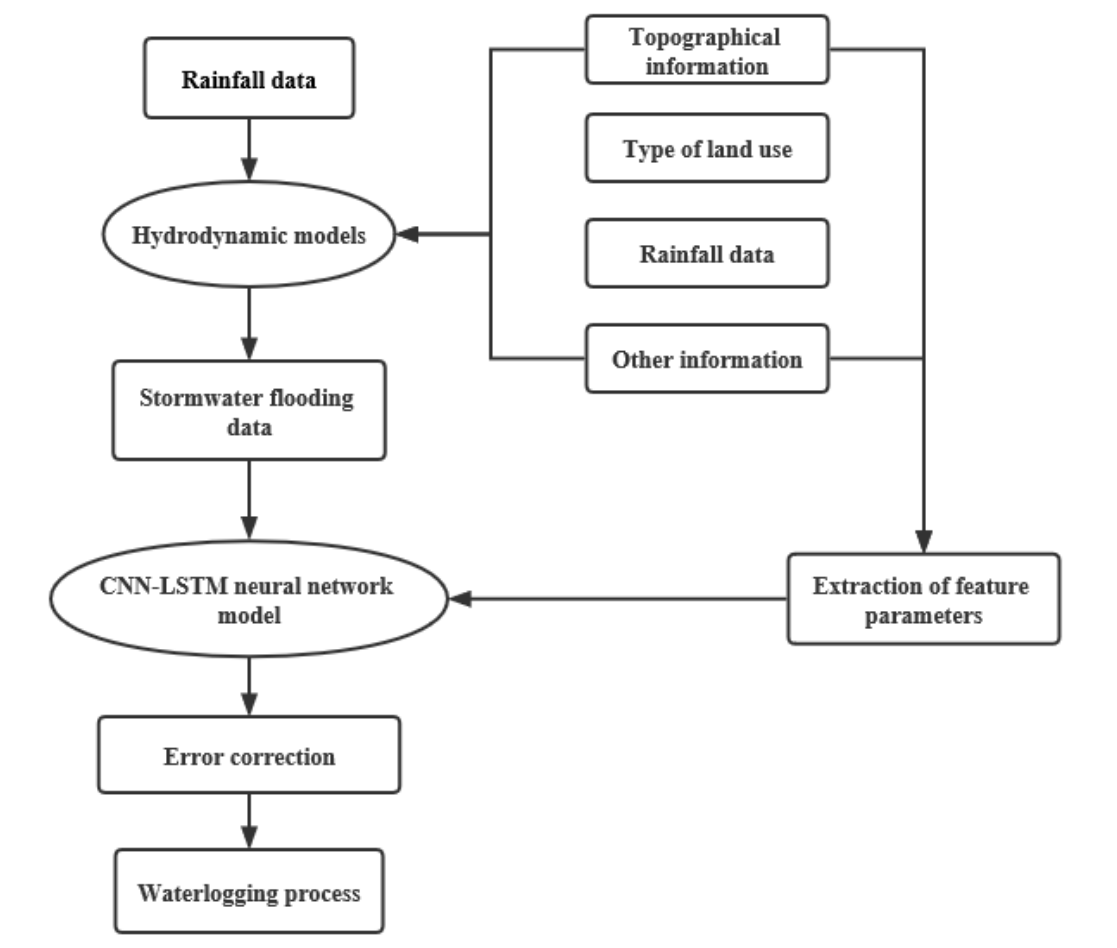
Figure 1. Technical flow chart.